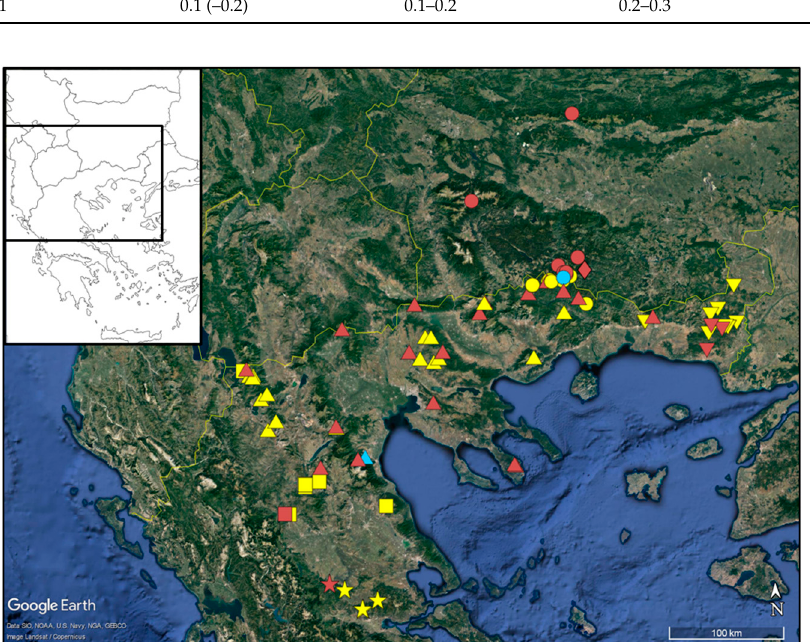
Figure 10. Distribution map of Anthemis macedonica group, showing the localities of the specimens collected by the authors (yellow and sky-blue colour) and those of the examined herbarium specimens (red colour). Triangles: A. macedonica subsp. macedonica ; circles: A. macedonica subsp. orbelica ; squares: A. meteorica ; stars: A. serpentinica ; reversed triangles: A. thracica ; rhombus: A. macedonica subsp. stribrnyi ; sky-blue triangle: possible hybrid between A. macedonica subsp. macedonica and A. meteorica ; sky-blue circle: possible hybrid between A. macedonica subsp. orbelica and A. pindicola .